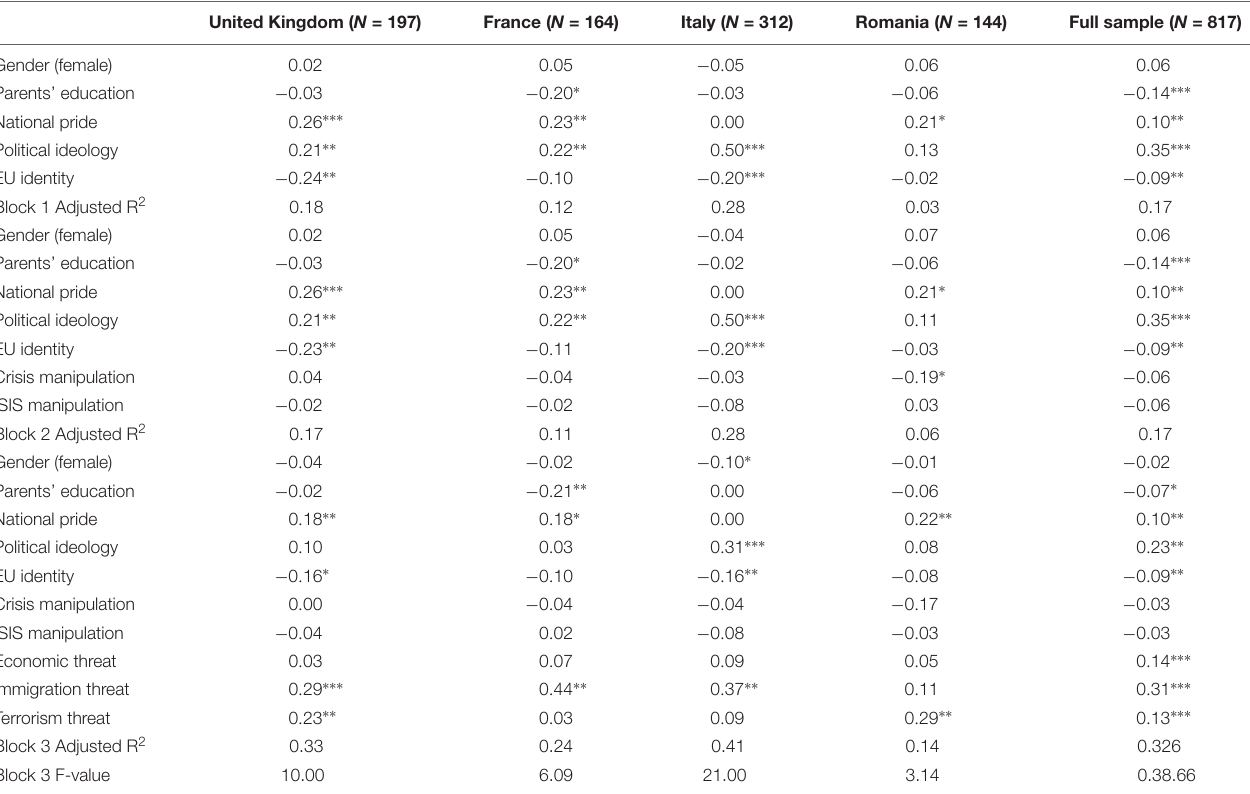
TABLE 3 | Standardized regression coefficients on the support for Eurosceptic parties (higher values mean higher support for Eurosceptic parties). United Kingdom ( N =